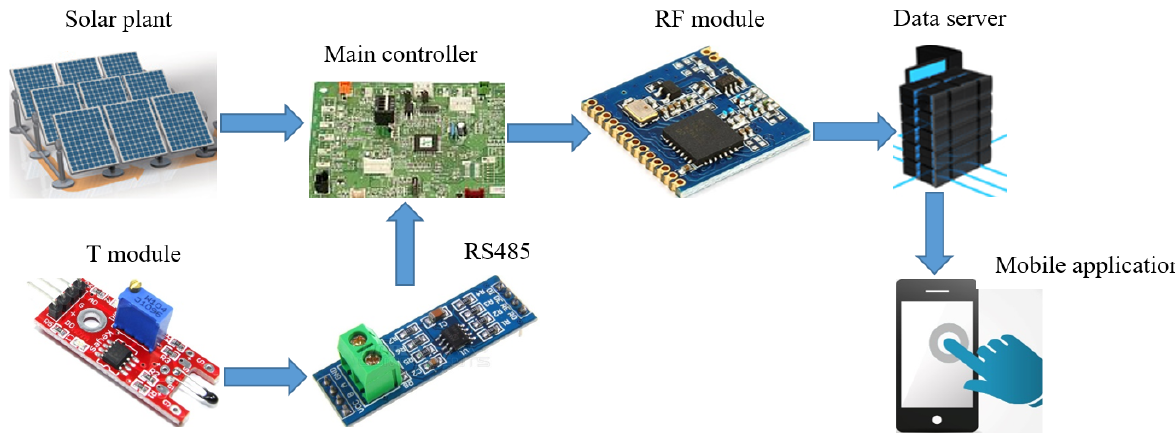
Figure 1. Block diagram of a hybrid data transmission network.